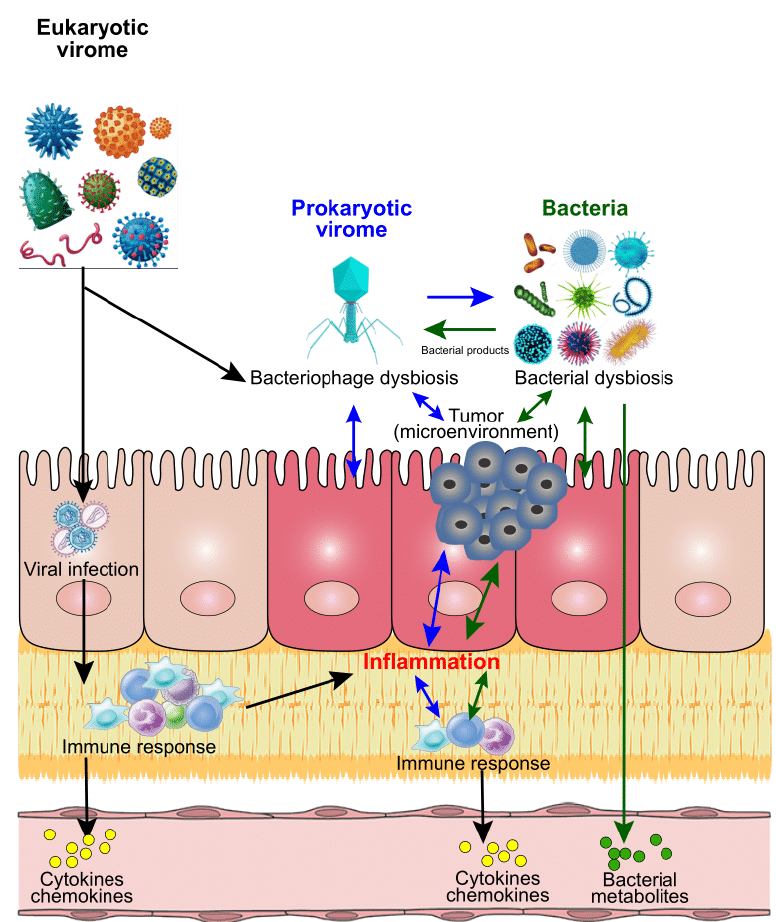
Figure 1. Proposed mechanisms of modulations of bacteria, virus, and CRC. After infection with eukaryotic viruses, the targeted host cells will be used for viral amplification and trigger the host immune responses by secreting cytokines and chemokines. These immune activities could result in inflammation in situ, or in other tissue/organs of the host, which could contribute to the initiation and process of cancer. Similarly, the bacterial infections could contribute to the inflammation via cytokines and chemokines from immune responses, or bacterial metabolites directly. Unlike the eukaryotic viruses, the prokaryotic viruses (mainly bacteriophages) mainly target the bacteria of the host after infection, and further impact on the host bacterial profiles. Meanwhile, the unbalanced bacteria could impact on the viral (both eukaryotic and prokaryotic virus) abundance and diversity through bacterial products. All these invaded organisms could directly or indirectly modulate the host microbial homeostasis, which contributes to the inflammation and tumour microenvironmental dysbiosis and further influence the cancer development and process.